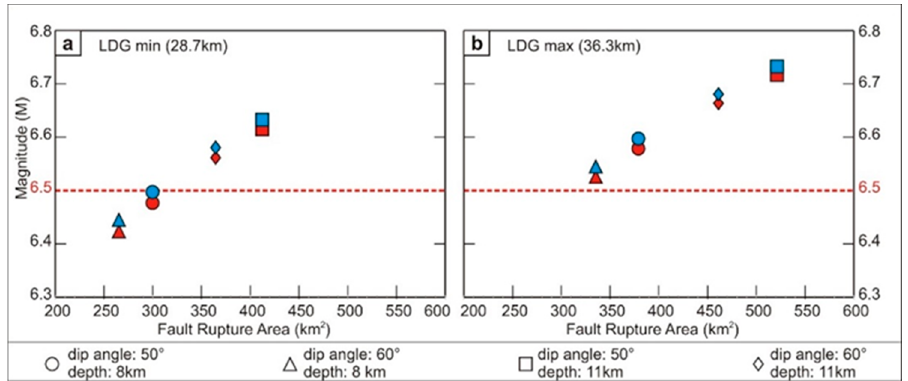
Figure 9. Earthquake magnitude estimates from Length of the Deforming Ground (LDG). ( a ) earthquake magnitude is estimated using LDG minimum, ( b ) earthquake magnitude is estimated using LDG